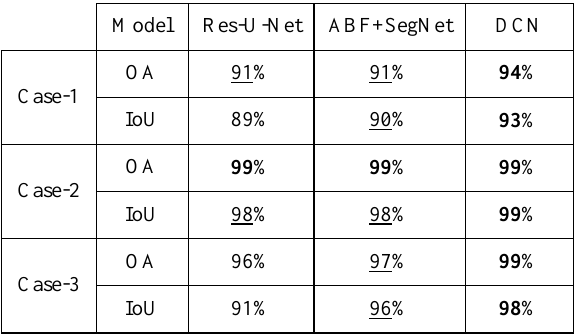
Table 3. Quantitative evaluation on the test area